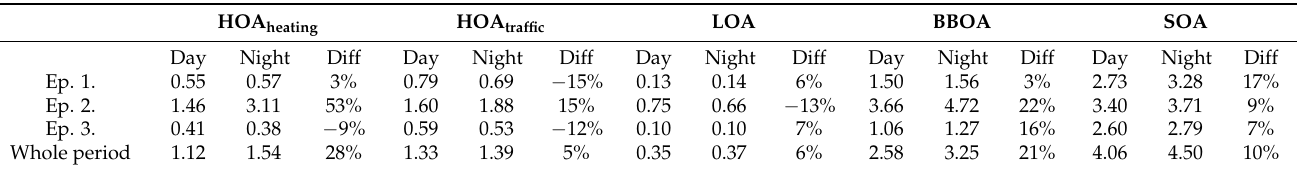
Table 1. Average of the factor concentration ( µ g m − 3 ) of the three episodes, during daytime (6 am–7 pm) and night-time (7 pm to 6 am) .